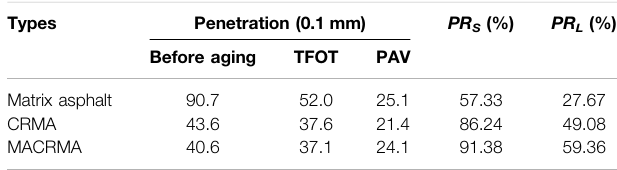
TABLE 3 | Penetration test results of three kinds of asphalts at different aging stages.